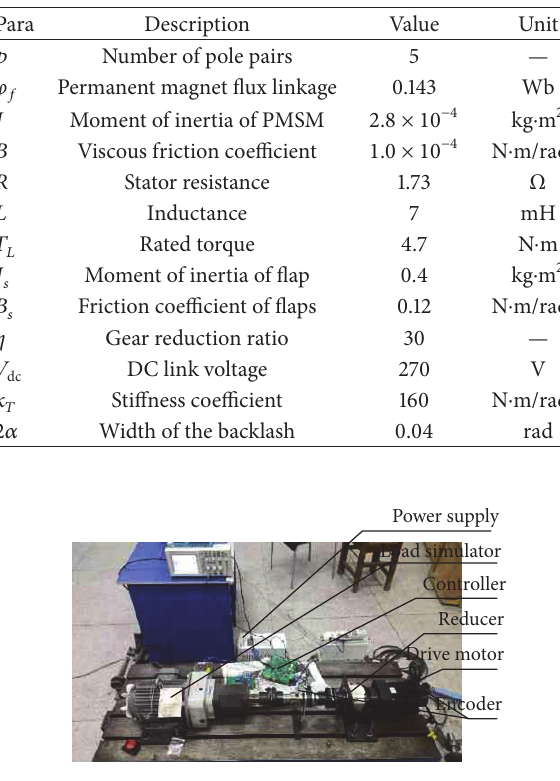
Figure 3: The experimental